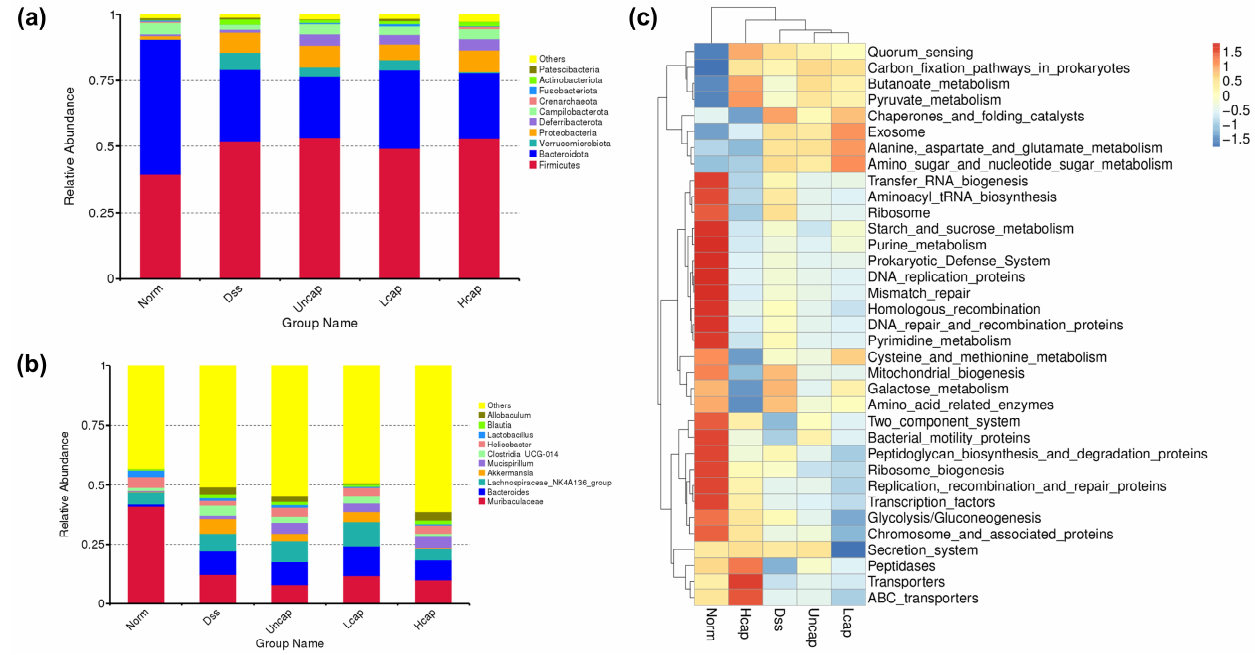
Figure 9. S. spongiosa polysaccharides remold the composition of intestinal microbiota. ( a ) The microbiota composition and proportion among five groups at the phylum level. ( b ) The microbiota composition and proportion among five groups at the genus level. ( c ) The cluster heatmap of the Tax4Fun Prediction Function among five groups.